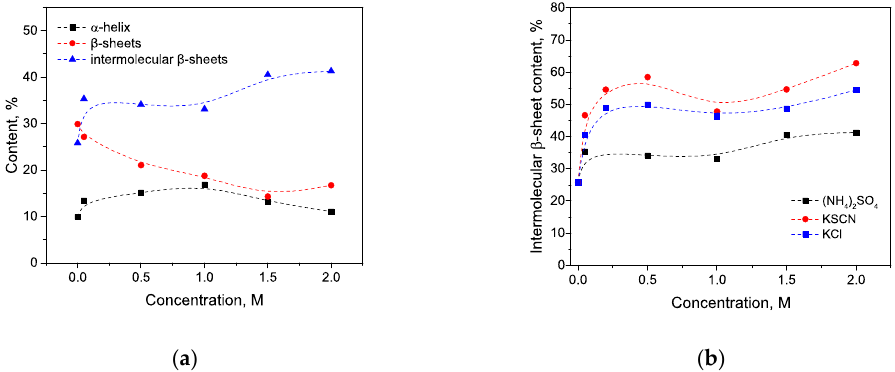
Figure 19. Changes in the secondary structure of trypsin depending on (NH 4 ) 2 SO 4 concentration ( a ) and salt-specific effects on intermolecular β-sheets of trypsin ( b ) in 20% wt. aqueous solution at 80 °C.